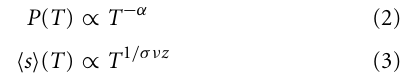
FIGURE 4 | Discriminability of the LFP spectra in relation to the avalanche statistics. (A) Discriminability index in the reduced simulations. As in the full simulations ( Figure 3B ), stimulus discriminability increases dramatically in a narrow region of the coupling space. (B) Avalanche size distributions P ( s ) in the sub-critical (green), critical (blue), and super-critical (red) regimes for a single stimulus. Insets show how the corresponding avalanche duration distributions P ( T ) and the mean avalanche sizes (cid:3) s (cid:4) conditioned on the avalanche duration T behave in the three distinct regimes. The corresponding coupling parameter values are marked with crosses in (A) . (C) The values of the estimated power-law exponents τ , α , and 1 /σν z for each value of the excitatory coupling strength J exc . The lines mark the mean exponent at the critical point for each stimulus and the corresponding colored patches represent the standard deviation over the stimuli. The black dashed line shows the value of α computed using Equation 3, by plugging in the other two